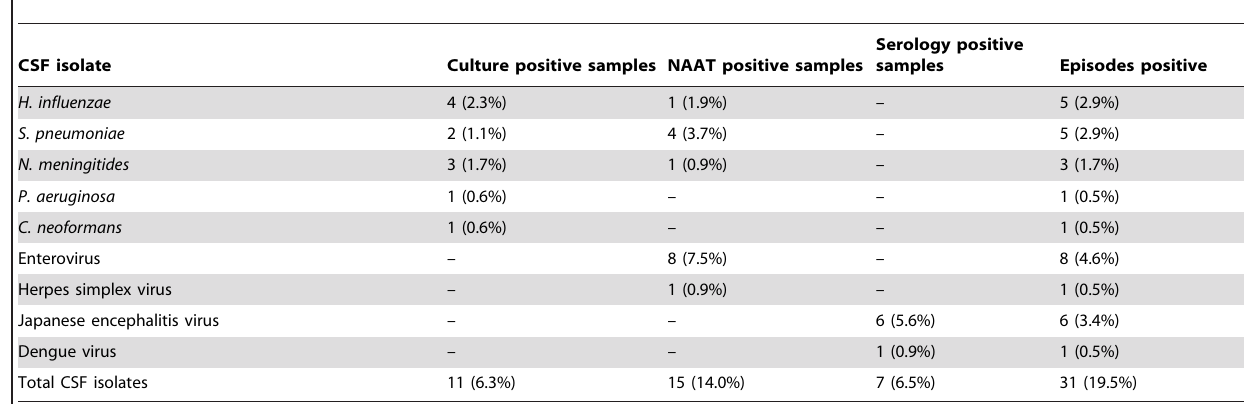
Table 5. CSF microscopy and culture ( n = 174), NAAT ( n =107) results, and total episodes positive ( n =174) by all methods for children with suspected CNS